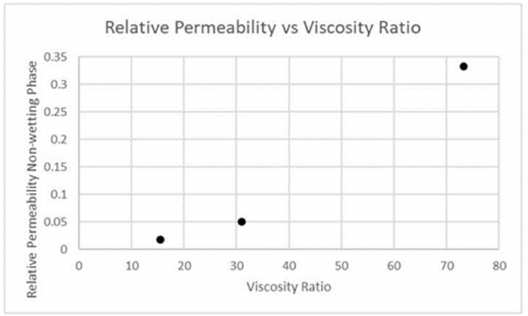
Figure 20. Relative permeability as a function of viscosity